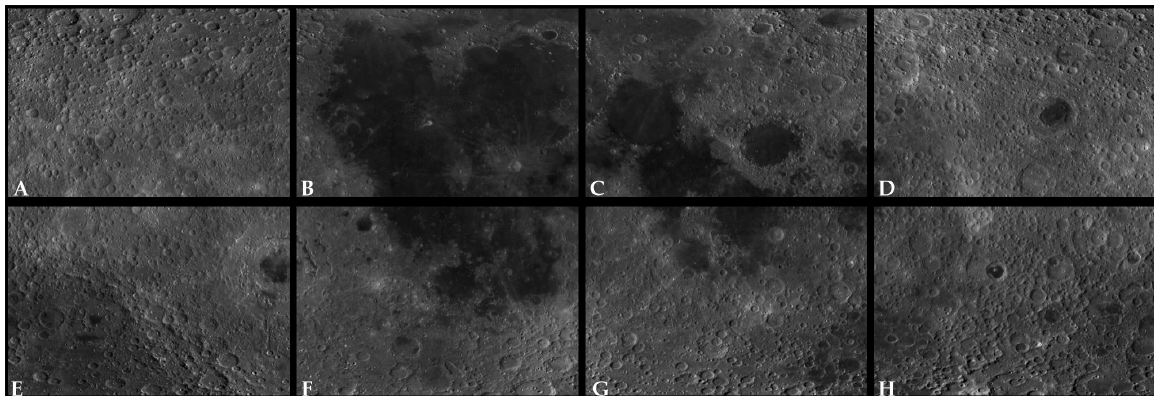
Figure 2. Eight regions of the WAC from the Lunar Reconnaissance Orbiter Camera in the longitude range [ − 60°, 60°] and latitude range [ − 180°, 180°] for the lunar image. Letters ( A – H ) denote different regions.